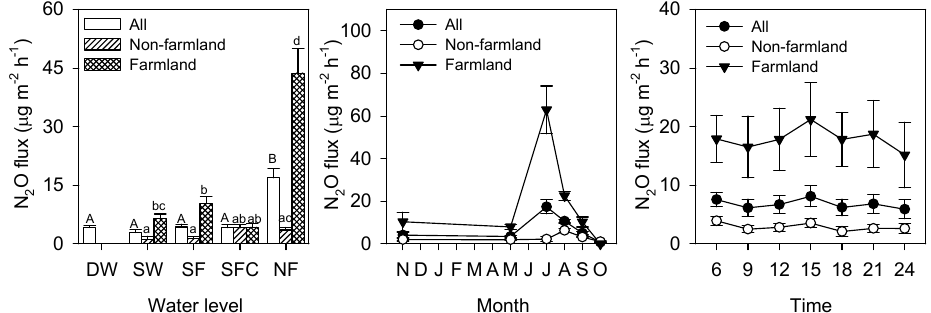
Figure 4. N 2 O flux (mean ± SE) at different water levels, months and times of day. Farmland included four plots, i.e. SW-C, SF-C, SFC-C and NF-C, which grew maize in the sampling growing season or the last growing season. Non-farmland included other 11 spots (see Table 1 for details of vegetation). DW: deep water site; SW: shallow water site; SF: seasonally flooded site; SFC: “control site” for the seasonally flooded site; NF: non-flooded site. Bars with different letters indicate a significant difference at p < 0.05. Difference analysis of bars with capital letters and small letters was done separately. Table 2. ANOVA table to test the effects of water level, sampling month and time of day on N 2 O flux. The category of farmland included four plots, i.e. SW-C, SF-C, SFC-C and NF-C, which grew maize in the year of the study or the previous year. The category of non-farmland included other 11 spots (see Table 1 for details of